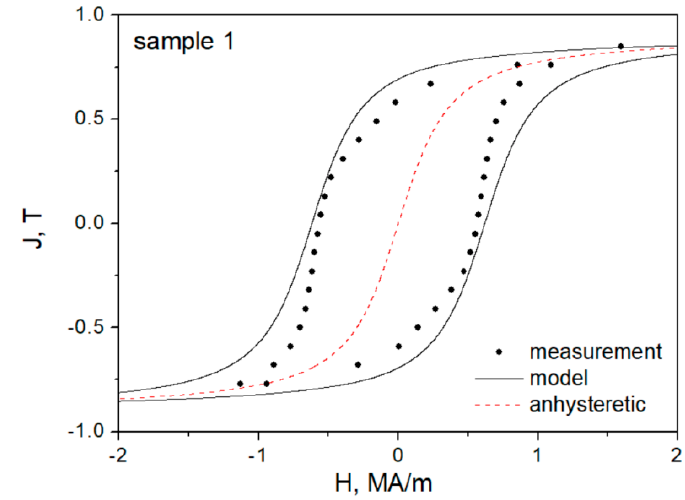
12 of 18 Figure 9. An attempt to model the hysteresis loop of Sample 1 using two term polynomials for the description of the irreversible field component. As the fitting criterion, we used the sum of the squared deviations between the meas- ured and modeled values for the remanence and the coercive points. For the remanence point, the value of the irreversible field strength component is compensated by the value of the anhysteretic field strength, thus the resultant field strength is reduced to zero. On the other hand, the value of the coercive field strength should be equal to the value achieved at the bifurcation threshold. These two statements allowed us to develop a cri- terion for the minimization of the total energy function, perceived as the sum of two non- negative terms; thus, dependent on a and b , the solution of the minimization problem should yield the optimal values of the parameters. The computations were carried out in a spreadsheet.